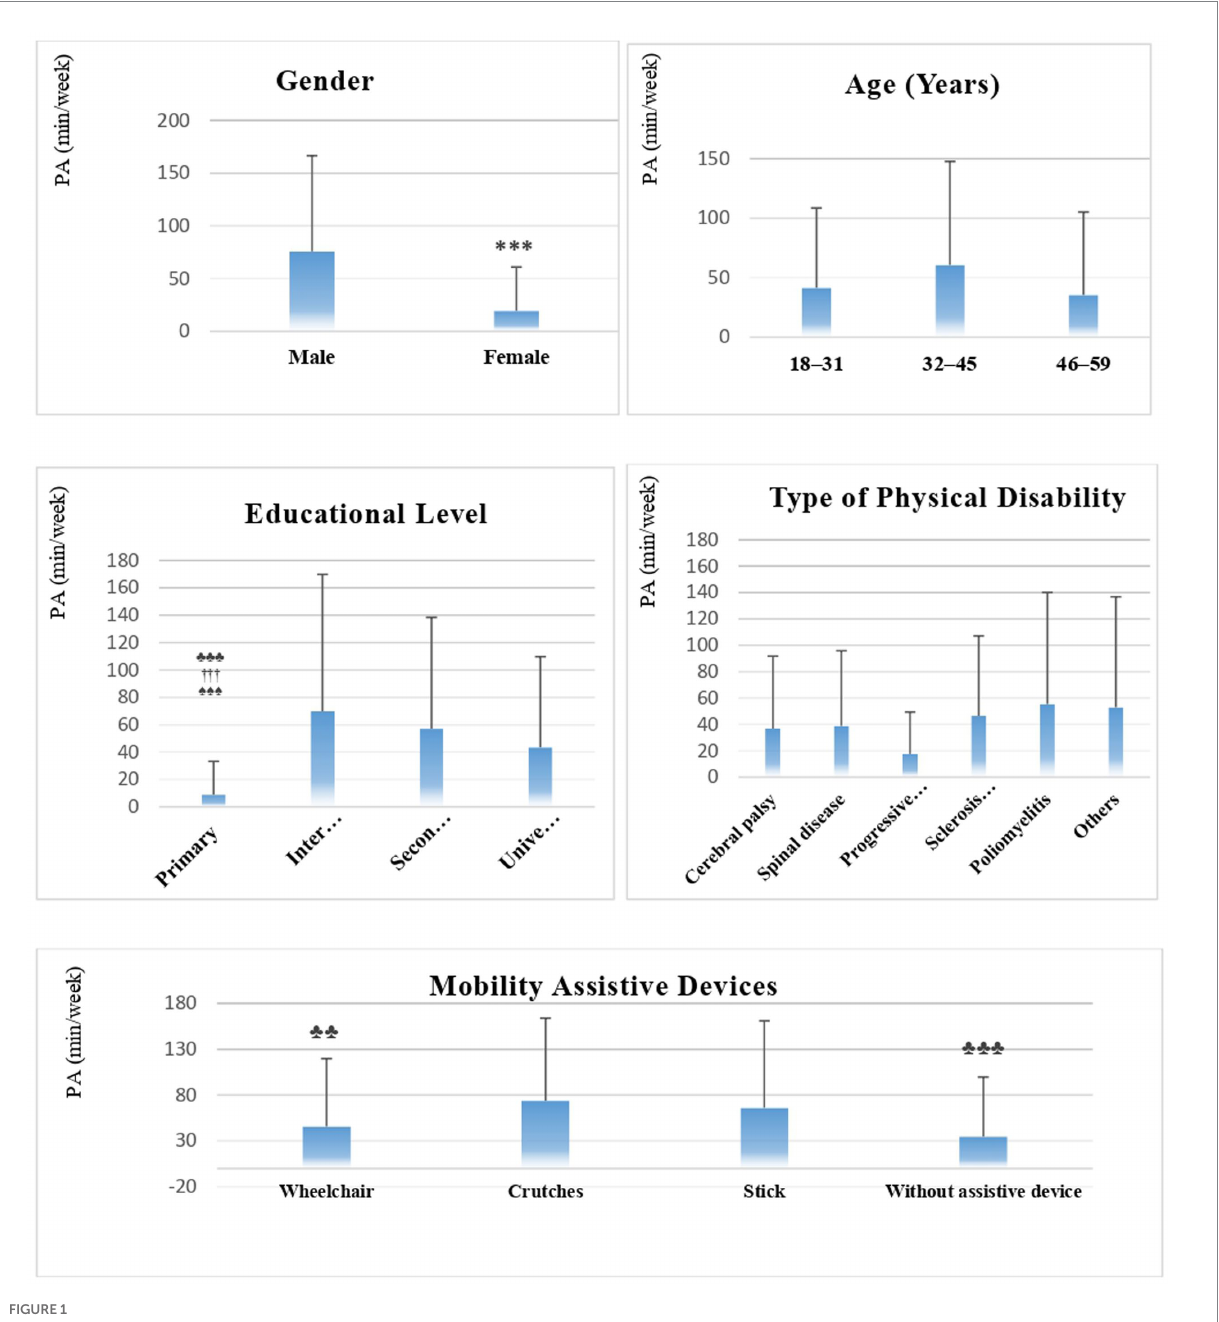
FIGURE 1 Weekly physical activity levels according to sociodemographic variables in Saudi participants with physical disabilities ( N = 582). PA, physical activity. *** < 0.001 differs from subgroup 1; ♣♣ < 0.01, ♣♣♣ < 0.001 differs from subgroup 2; ††† < 0.001 differs from subgroup 3; ♠♠♠ < 0.001 differs from subgroup